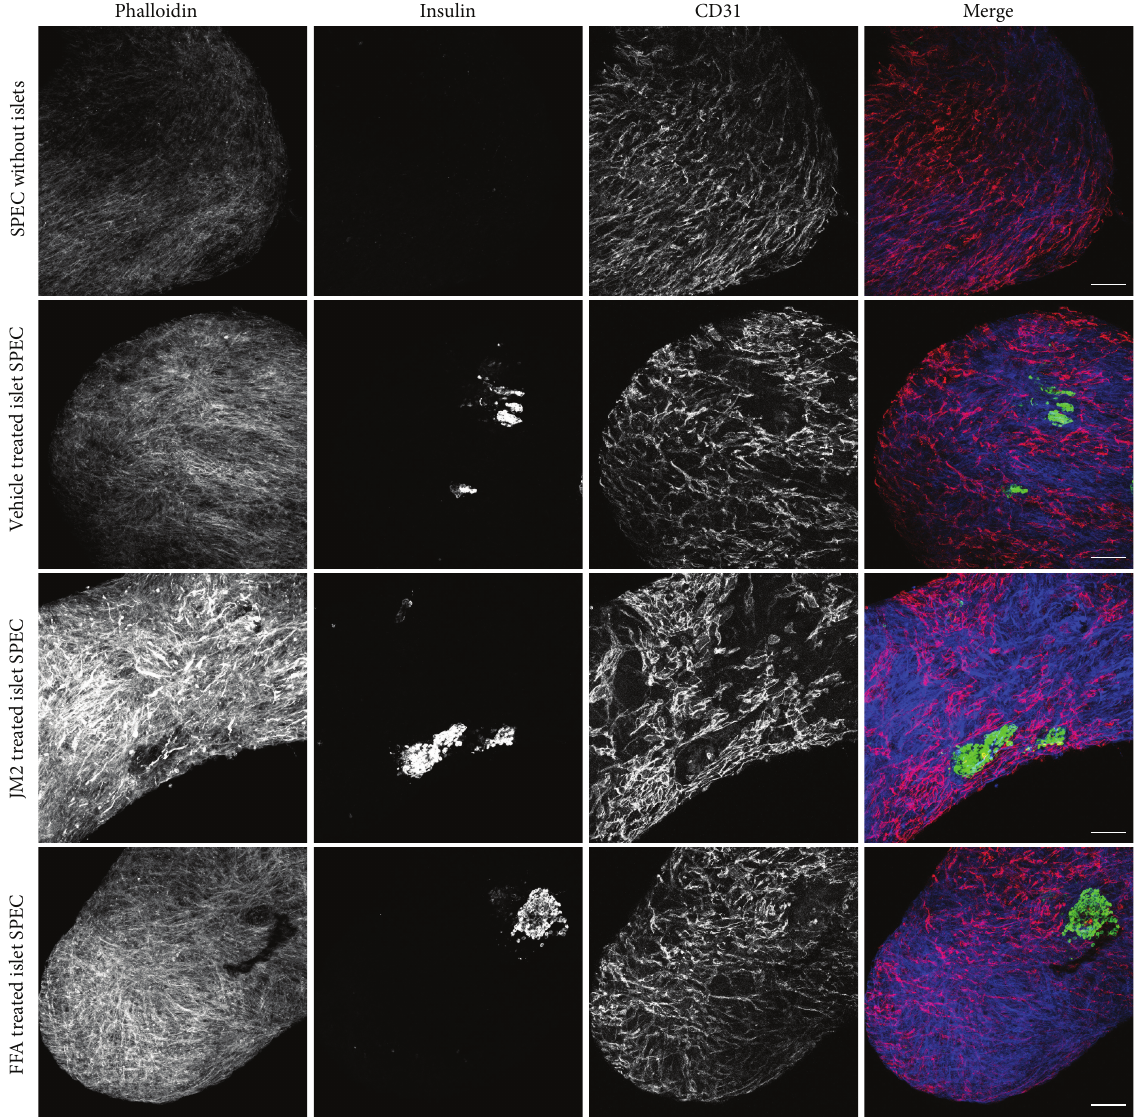
Figure 4: Prevascularized bioartificial pancreases subjected to JM2 treatment retain robust insulin expression and maintain a vascular network. The constructs used in the GSIS assay were fixed, whole-mount-labeled, and imaged by confocal microscopy. The labels used were for actin (phalloidin, blue), islets (insulin, green), and endothelial cells (CD31, red). Note the persistence of a vascular network in the constructs subjected to GSIS assay (Vehicle, JM2, and FFA). Importantly, the level of insulin expressed is comparable in vehicle and JM2- treated constructs, while this appears to be decreased in FFA-treated SPECs. Images aremaximum projections of z-stacks of 20x magnification fields. Scale bars represent 100 𝜇